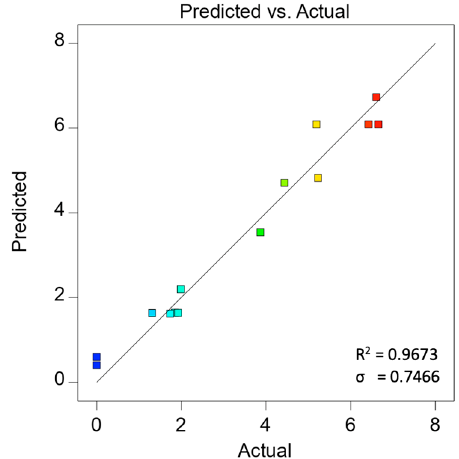
Figure 2. Predicted versus actual values for HER rate based on second-order polynomial regression.